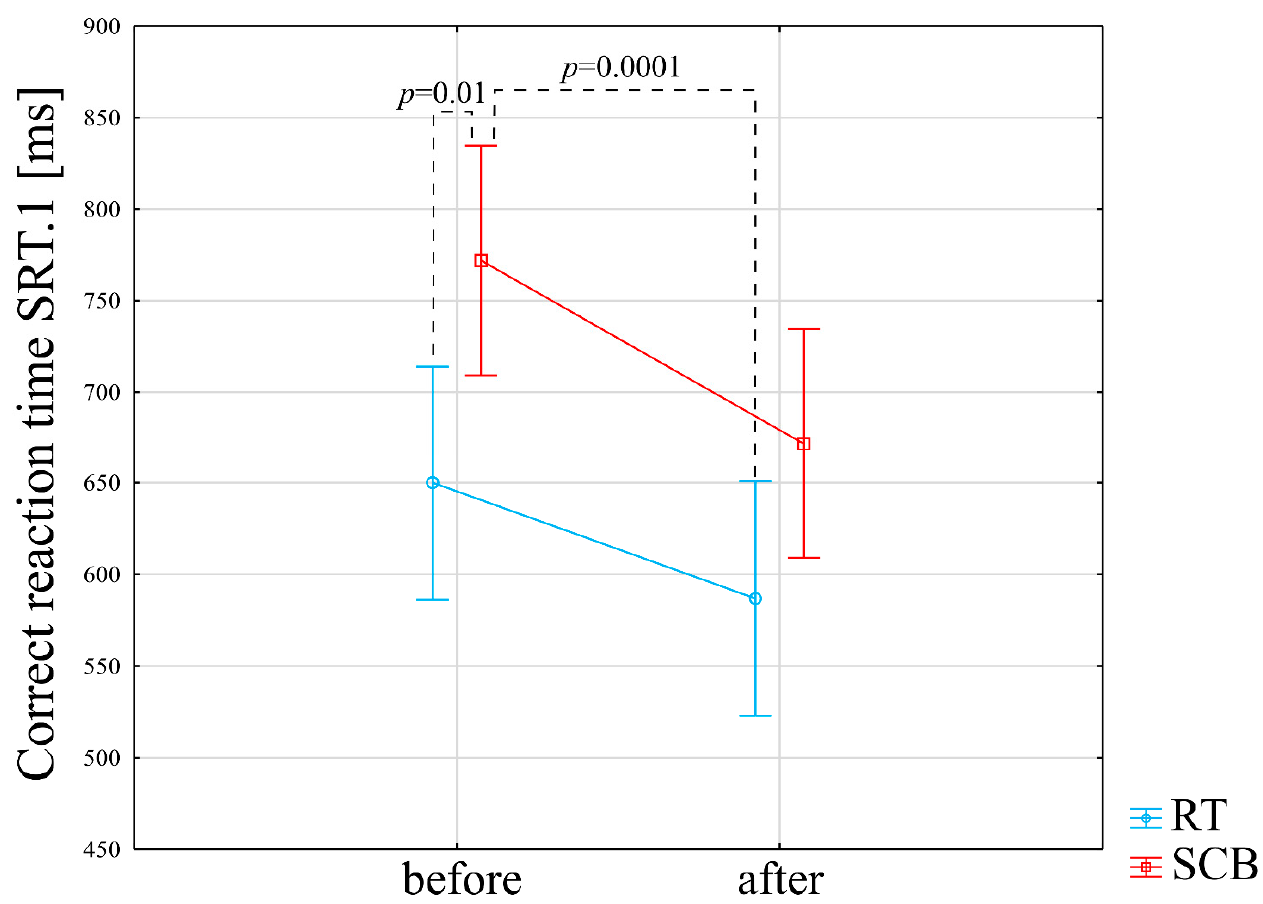
Figure 3. Impact of training programs on reaction time in the SRT1 score.